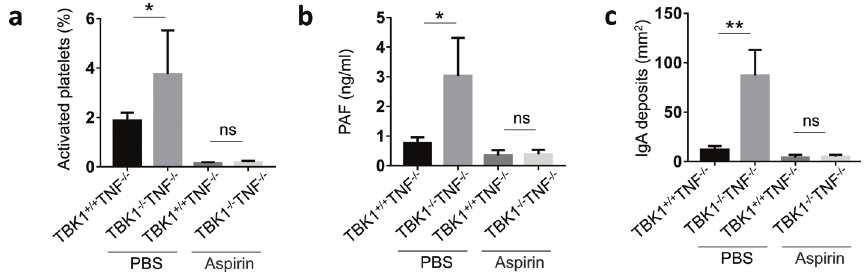
Fig. 3 . Aspirin suppressed the deposition of IgA in glomeruli caused by TBK1 deficiency. The WT and TBK1 -/- TNF -/- mice were treated with aspirin (200 mg/kg) each week for three times. (a) Platelet activation in the plasma of the mice treated as above with PMA. (b) The protein level of PAF in the serum from aspirin-treated WT and Tbk1 -/- TNF -/- double knockout mice were assessed by ELISA assay. (c) Quantification of immunoglobulin deposits. The data were expressed as means ± standard error of mean (SEM). Results represent mean values of three independent experiments. *, P < 0.05; **, P < 0.01.